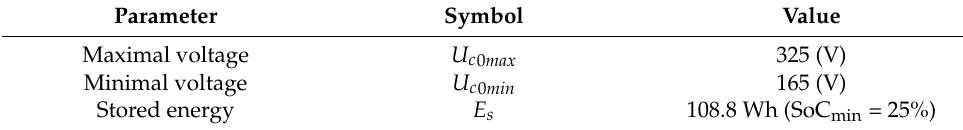
Table 2. UC characteristics.